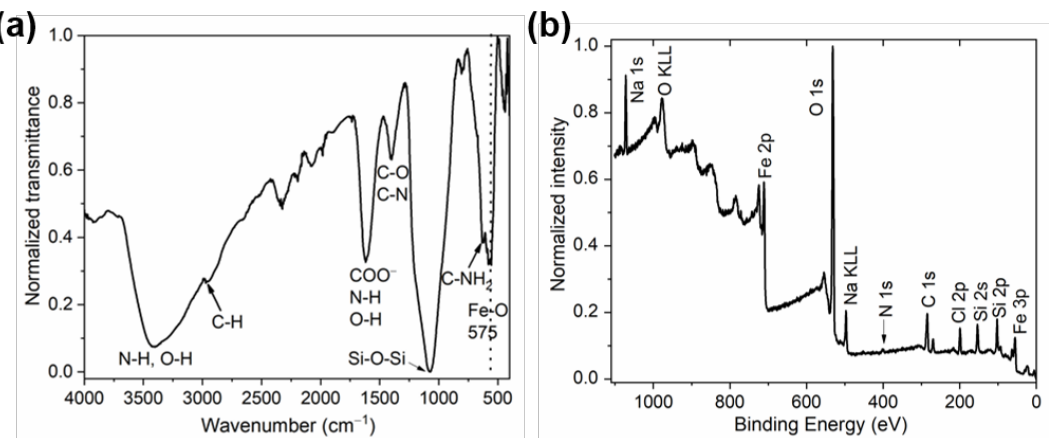
Figure 5. ( a ) The ATR-FTIR spectrum and ( b ) XPS survey spectrum of MNPs@SiO 2 @Lys.